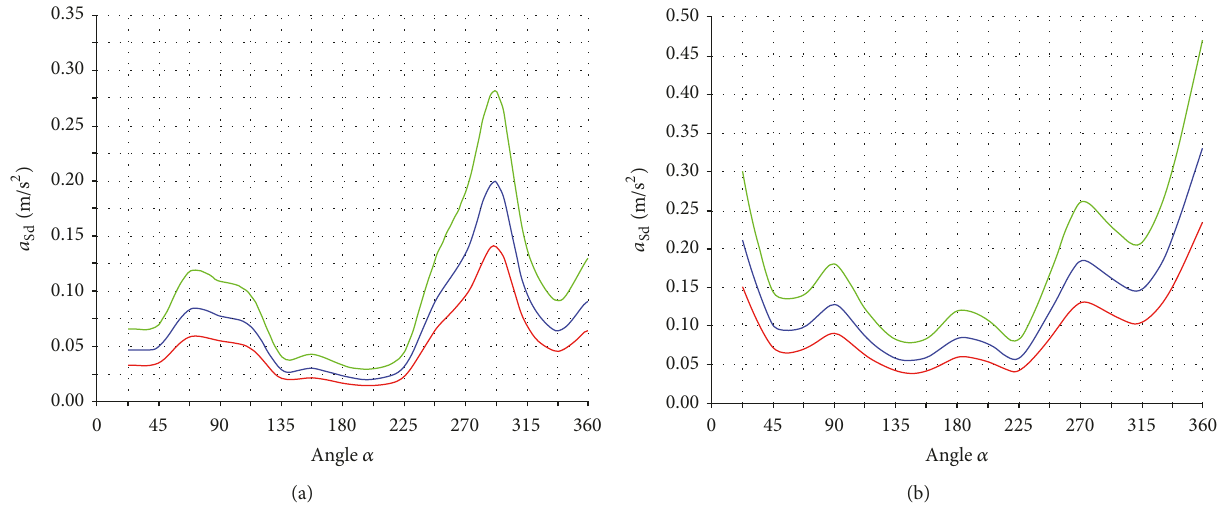
Figure 8: Acceleration response for different damping ratios 𝜉 : (a) in 𝑥 -direction and (b) in 𝑦 -direction (the torsional component is considered).